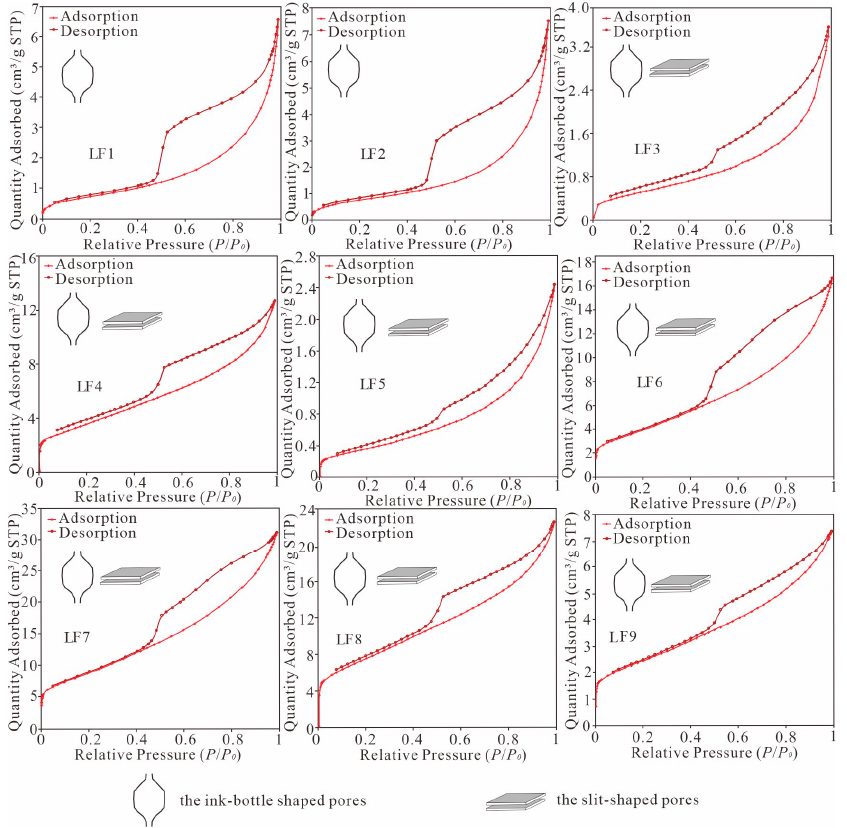
Figure 9. The physisorption isotherms and hysteresis loops of the nine lithofacies in Es4s Dongying Depression.